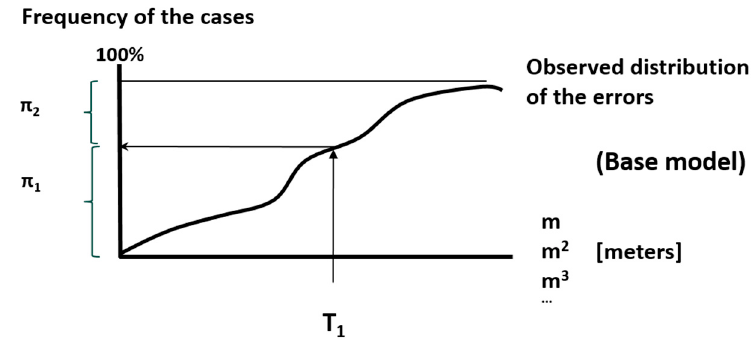
Figure 3. Key elements of a control by proportions.